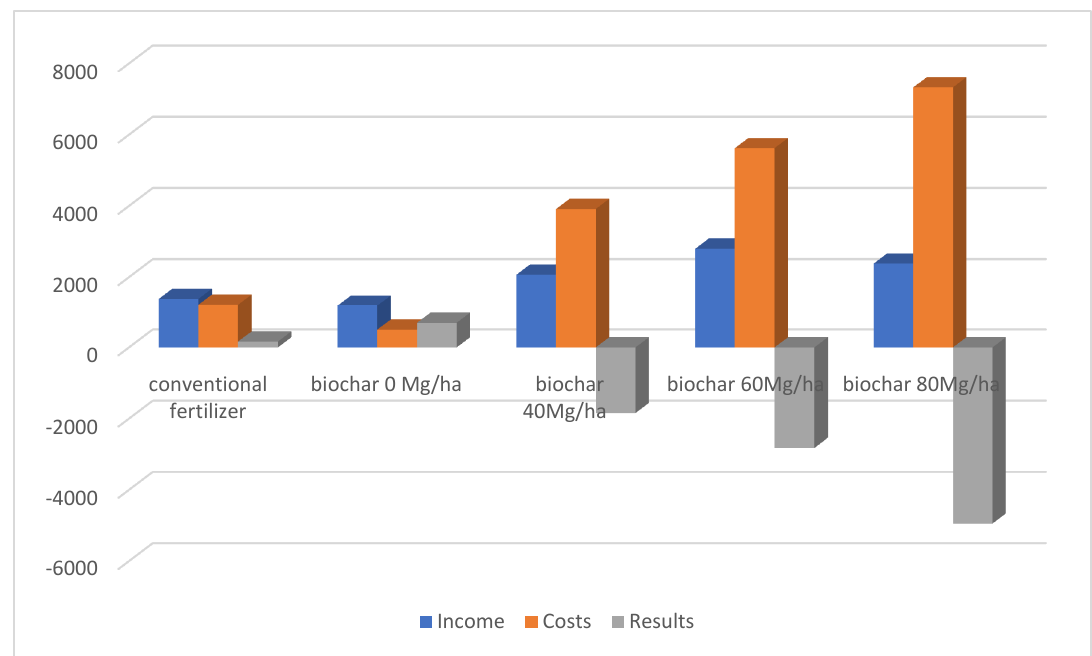
Figure 5. Comparison of the income and costs (in USD) of conventionally fertilized crops (those fertilized twice a year) and with the addition of biochar. Table 3. Comparison of the financial results for single and double soil fertilization with conventional fertilizer.